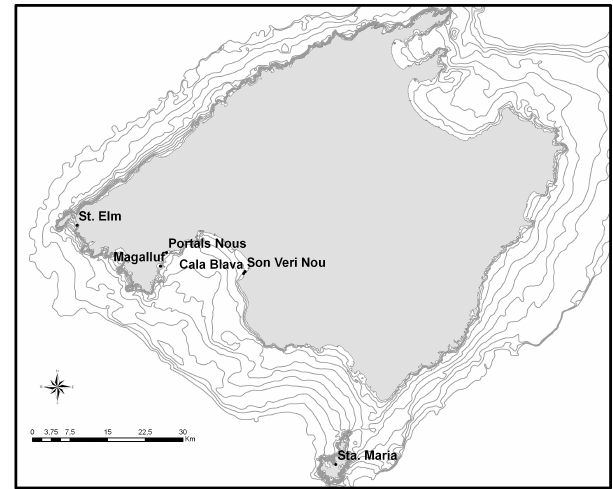
Fig. 1. Geographical location and sample sites of the study area in the Balearic Islands (western Mediterranean). Continuous lines show